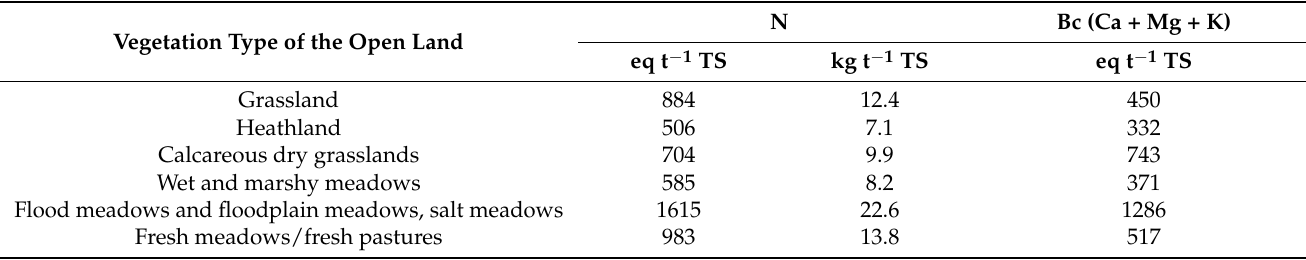
Table 10. Net substance content in the dry matter (DM) of the above-ground biomass of the forest-free near-natural ecosystems [99–113] (5th